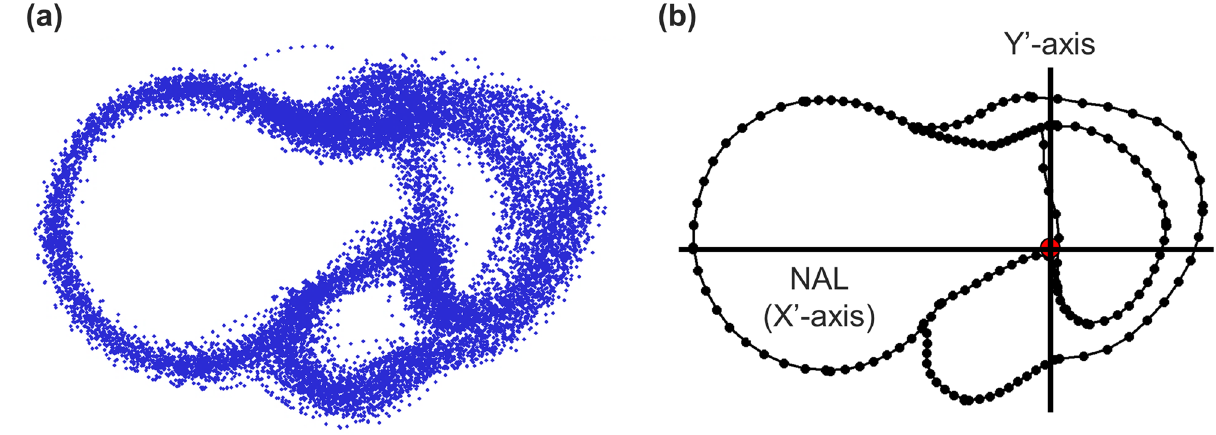
Figure 3. ( a ) The consensus of all landmarks using generalised Procrustes analysis was shown. ( b ) To describe major trends in shape variations within the sample, we performed a principal component analysis of the partial warp variables. The X ′ -axis was parallel to the native anteversion through the extension point of the femoral canal centre, which was equal to the native anteversion line (NAL). The Y ′ -axis was perpendicular to the X ′ -axis. The red point shows landmark 11, the extension line of the centre of the femoral canal